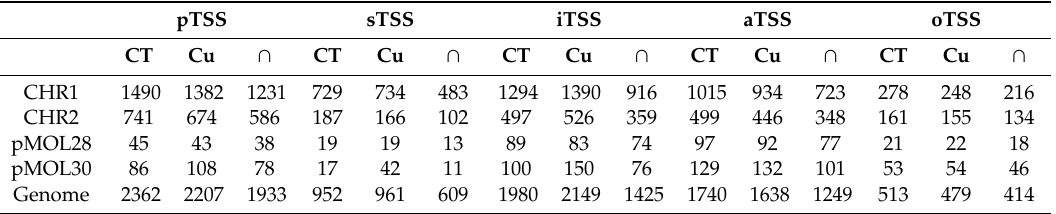
Table 2. Number and overlap of detected transcription start sites (TSSs) in each replicon 1 .